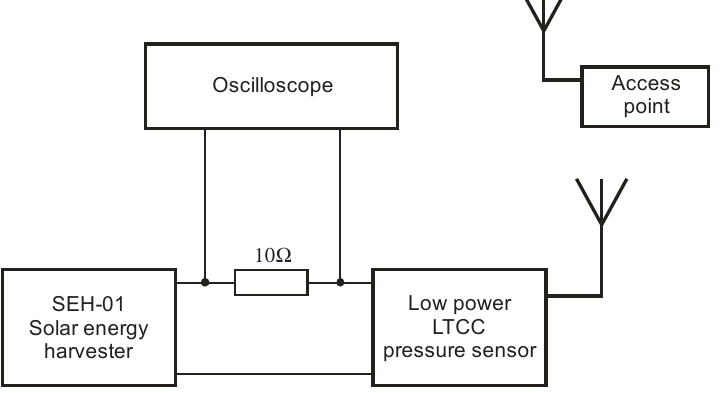
Figure 11. Low-power testing system for LTCC-based pressure sensor.